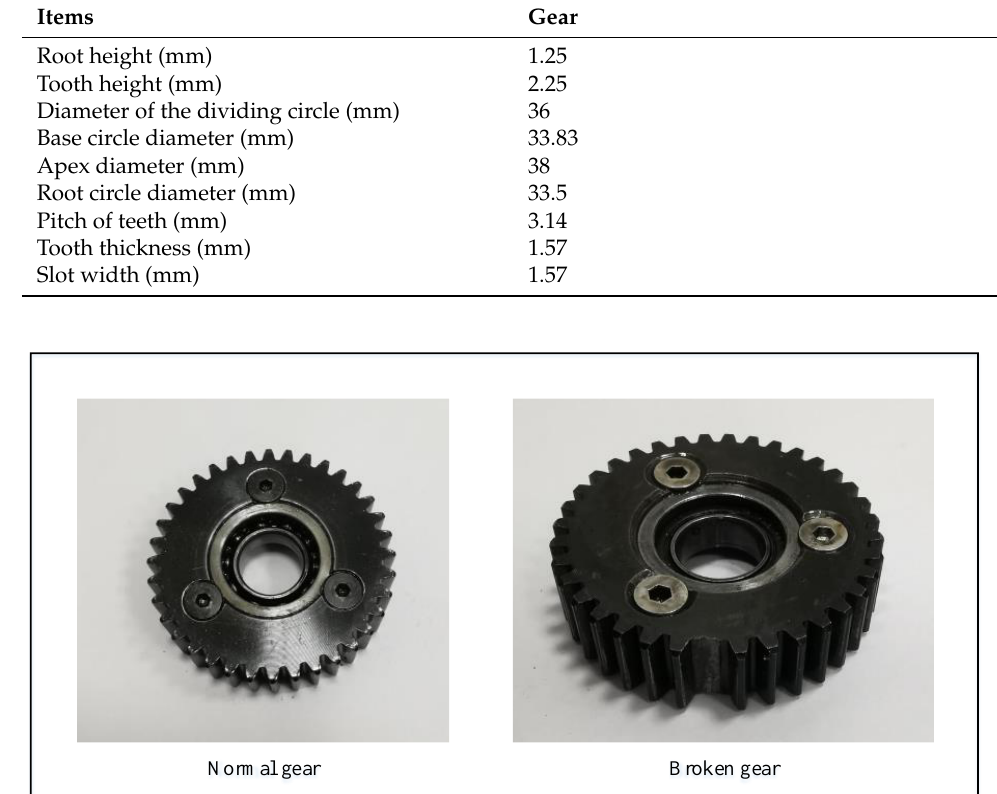
Figure 11. Experiment with planetary gears in different states. Table 2. Gear main parameters and geometric dimensions.